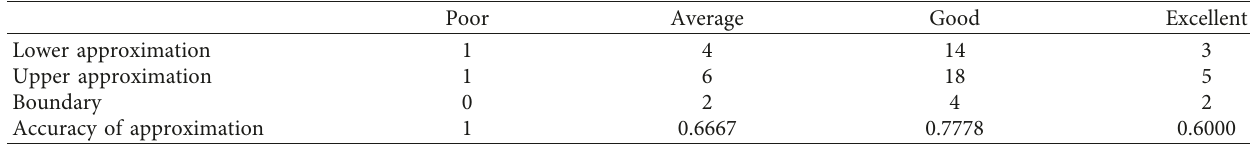
Table 4: Approximation sets and accuracy of approximation.